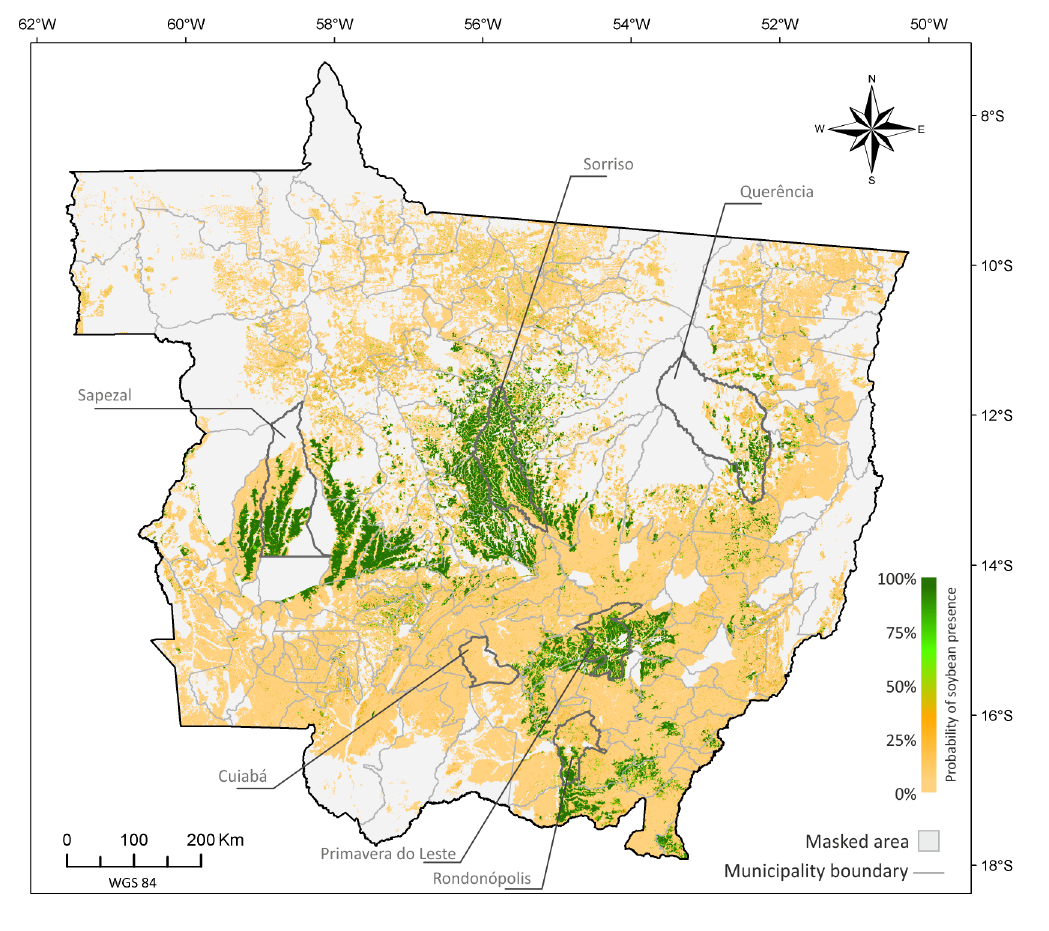
Figure 9. Probability Image (PI) of soybean presence for the entire Mato Grosso State, Brazil. Main soybean producer centers and the capital, Cuiabá, are highlighted. The color indicates the calculated probability of soybean presence in 2005/2006 given the observations made for the context variables, as expressed by Equation